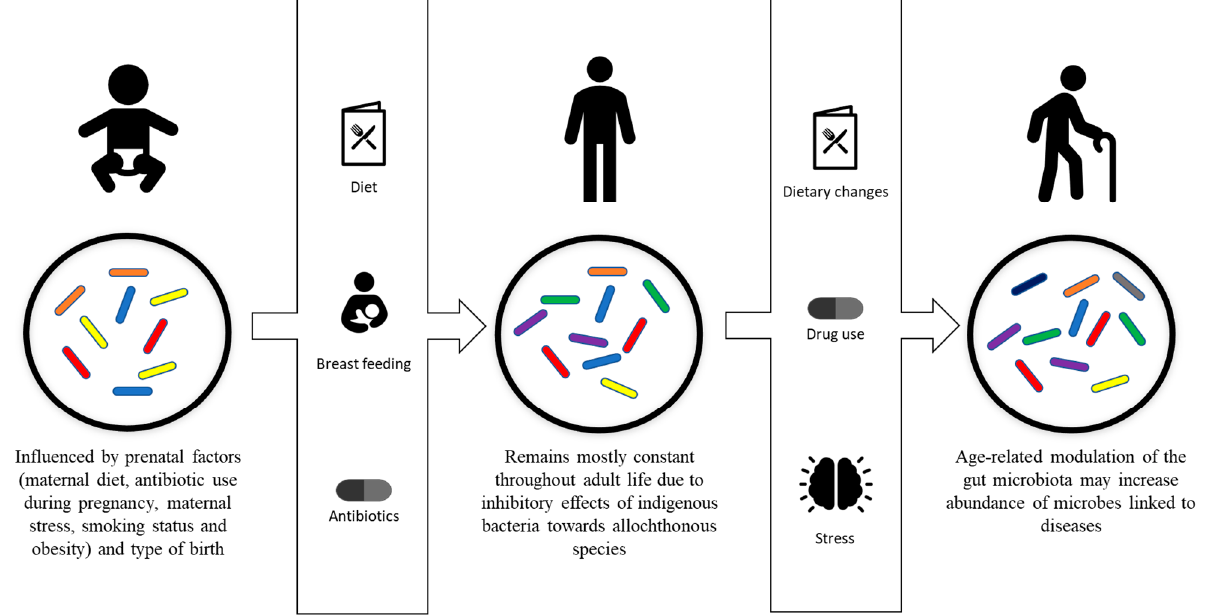
Figure 1. Development and modulation of the gut microbiota. Gut microbiota is initially influenced by prenatal factors, including maternal diet, antibiotic use during pregnancy, maternal stress, smoking status, obesity and type of birth. Breastfeeding, diet and antibiotic usage are the factors that affect the development of the gut microbiota into its stable adult composition. The adult composition of the gut microbiota may be modulated by drug usage, dietary changes, psychological stress and physiological stress.